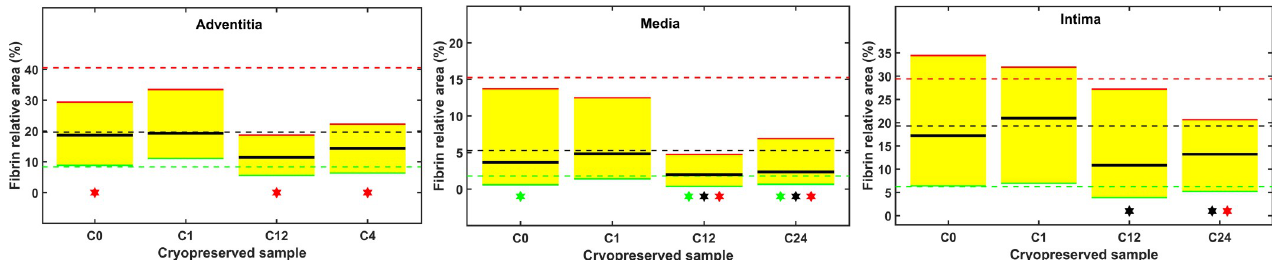
Fig 5. Qualitative quartile-wise comparison of the fibrin deposition on cryopreserved and native arterial allografts. Fibrin coverage of the separate arterial wall layers was measured as illustrated in Fig 3. Lower (green), median (black) and upper (red) quartiles of the measured coverage data are shown with dashed lines for the BC and continuous lines for the cryopreserved samples. The interquartile range of the cryopreserved samples is shadowed in yellow. Symbols indicate significant differences between the respective quartiles (green, lower quartile; black, median; red, upper quartile) of the BC and cryopreserved samples according to the cluster statistical approach described in Materials and